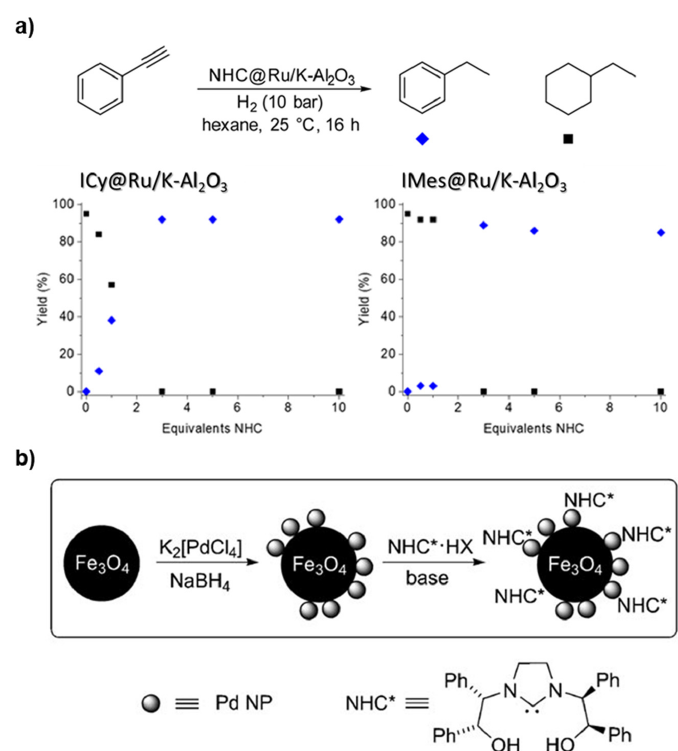
Figure 22. ( a ) Influence of NHC ‐ loading on the chemoselectivity in the hydrogenation of phenylacetylene. Extracted from reference 102. Copyright 2016 American Chemical Society. ( b ) Synthesis of Fe 3 O 4 /Pd NPs modified by chiral NHCs. Reproduced from reference 18. Copyright 2010 Willey ‐ VCH.